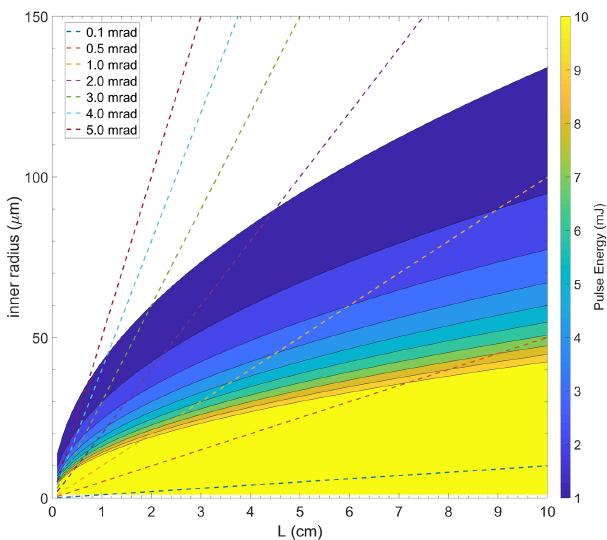
FIG. 8. Operational regions for different beam divergences.